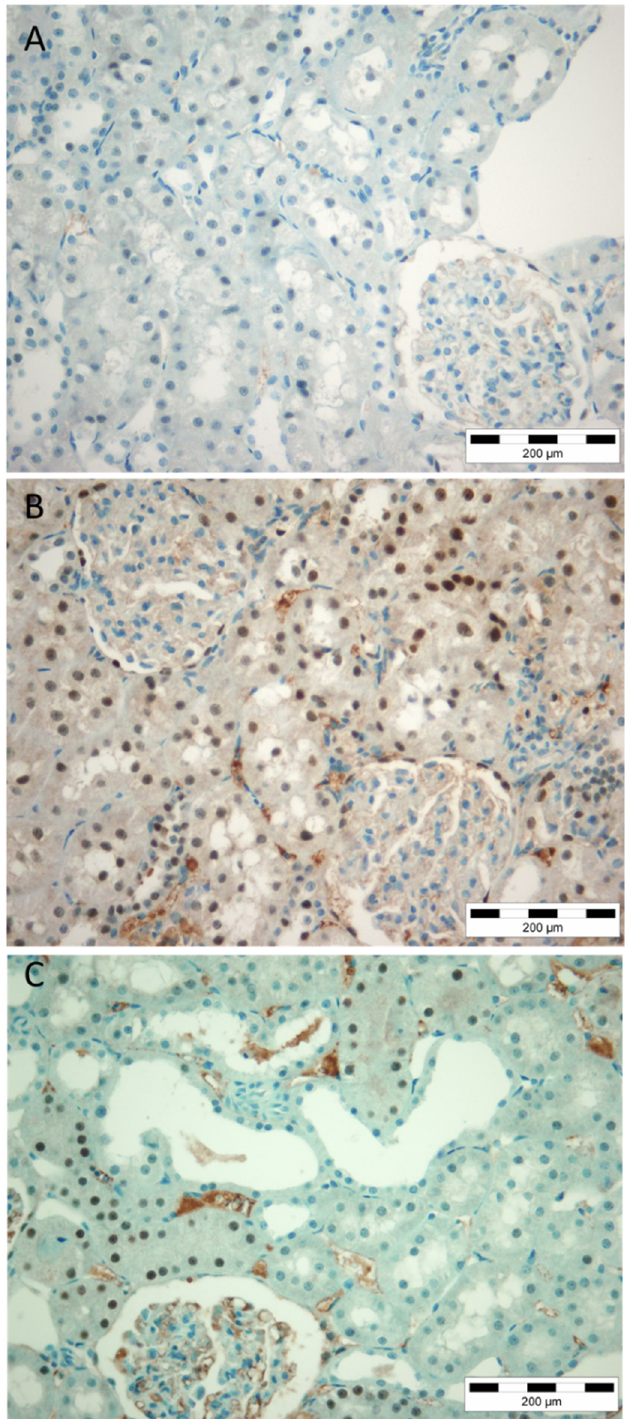
Figure 4. Immunohistochemical expression of PAX8 in rat kidneys with induced postischemic acute kidney injury. ( A ) Rare tubular epithelial cells with weak expression of PAX8 in control (sham operated) kidney. ( B , C ) Induction of PAX8 expression in proximal tubular epithelial cells in normotensive Wistar and spontaneously hypertensive rats after AKI induction.